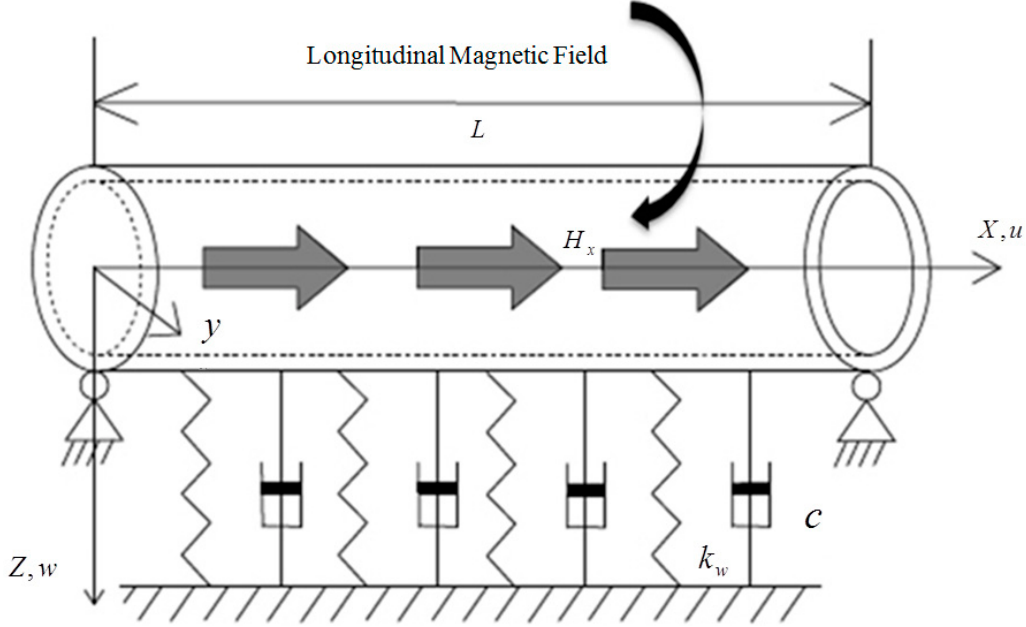
Figure 1. Mechanical model of single-walled carbon nanotubes.